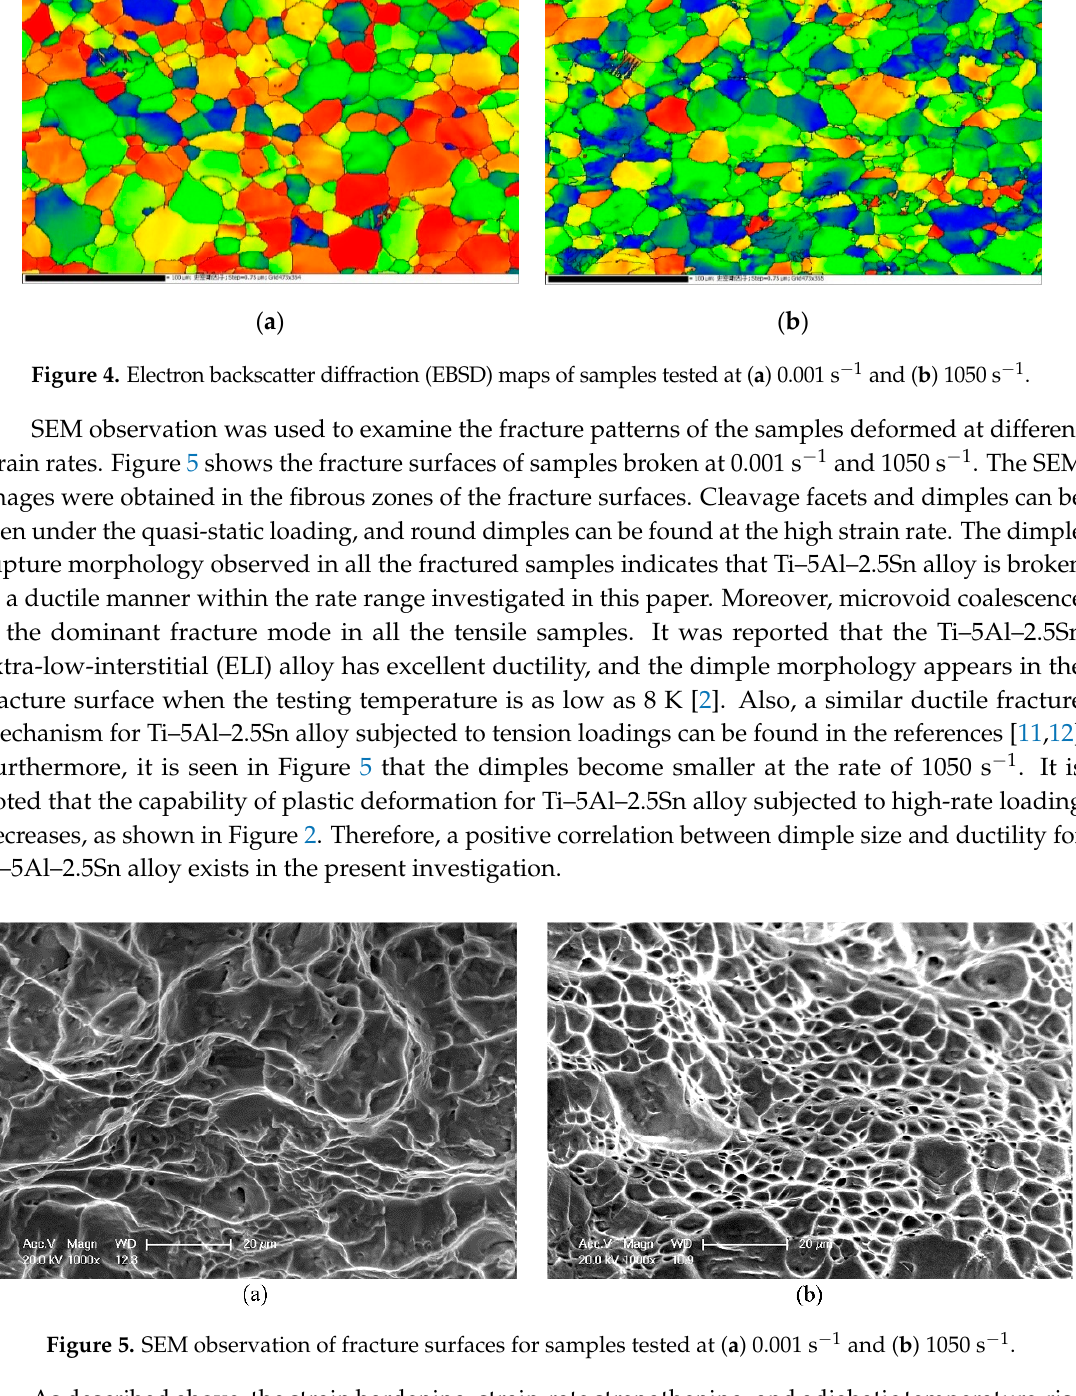
5 of 11 Figure 3. Flow stress versus logarithm strain rate. Table 2. Strain rate sensitivity (SRS) within various strain-rate ranges. Rate range (s − 1 )